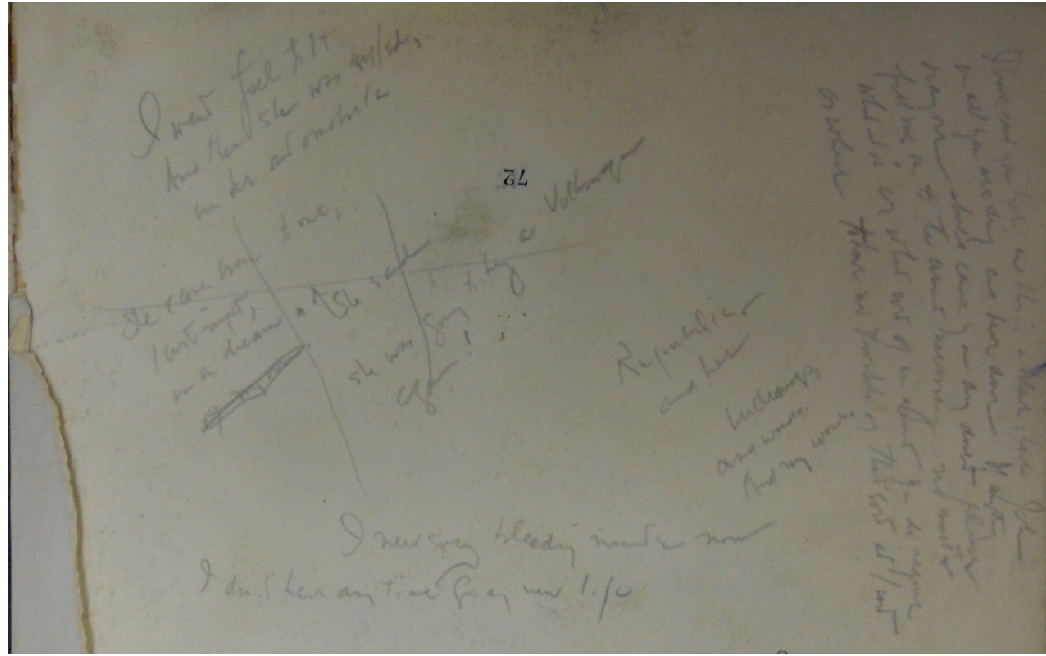
Figure 3. Page 72 of “Manuscript. Written on ‘Ace of Pentacles’ by John Wieners”, box 24, folder 1147, CORC.